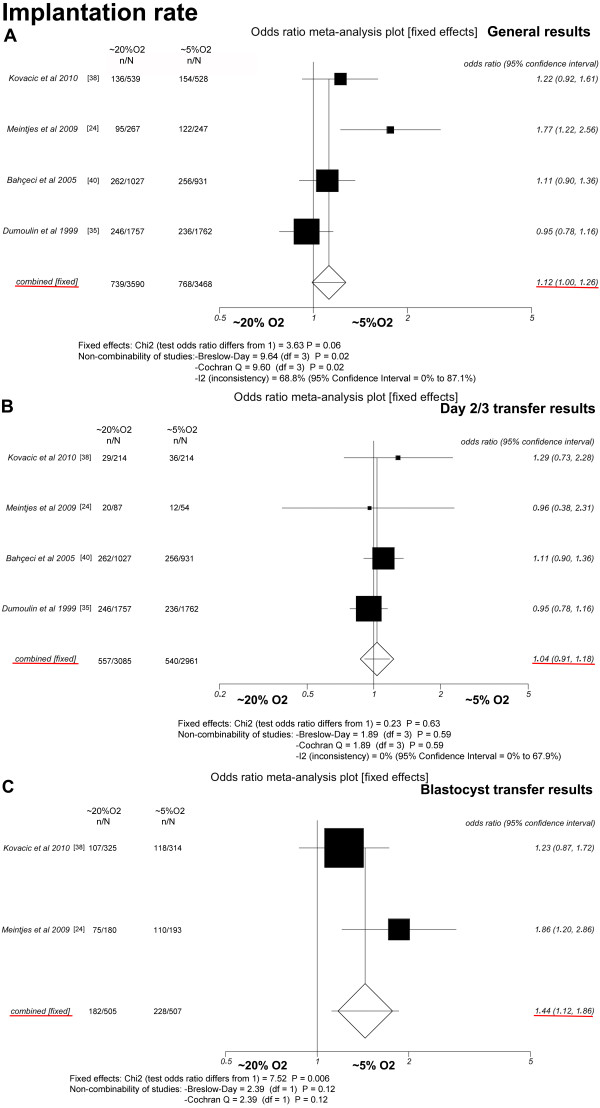
Fixed-effect model. Forest plot for implantation rate. A: All cycles; B: only cycles in which embryos were transferred on day 2 or 3; C: only cycles in which embryos were transferred at the blastocyst stage.